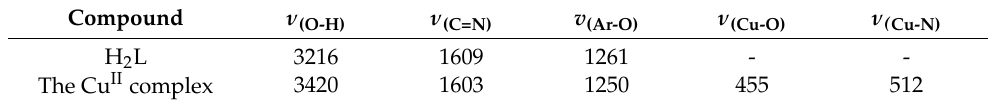
Table 2. The main IR bands for H 2 L and its Cu II complex cm − 1 .